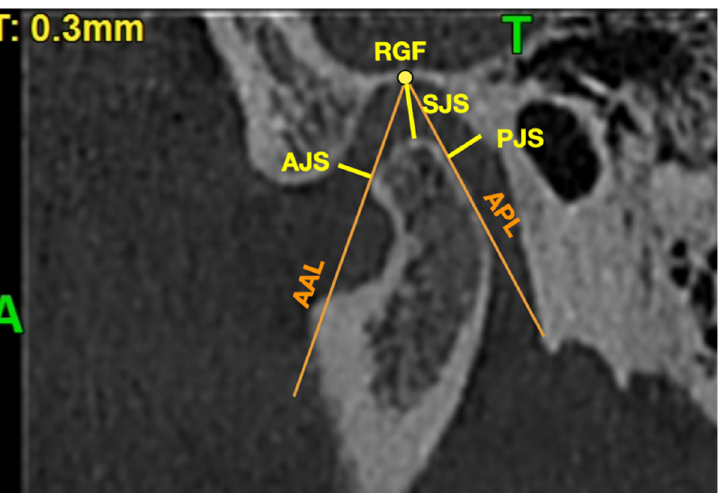
Figure 2. Sagittal view of the mandibular condyle with marked points and lines presented in Table 2. A—anterior, AAL—auxiliary anterior line, AJS—anterior joint space, APL—auxiliary posterior line, PJS—posterior joint space, SJS—superior joint space, RGF—roof of glenoid fossa, T—top.